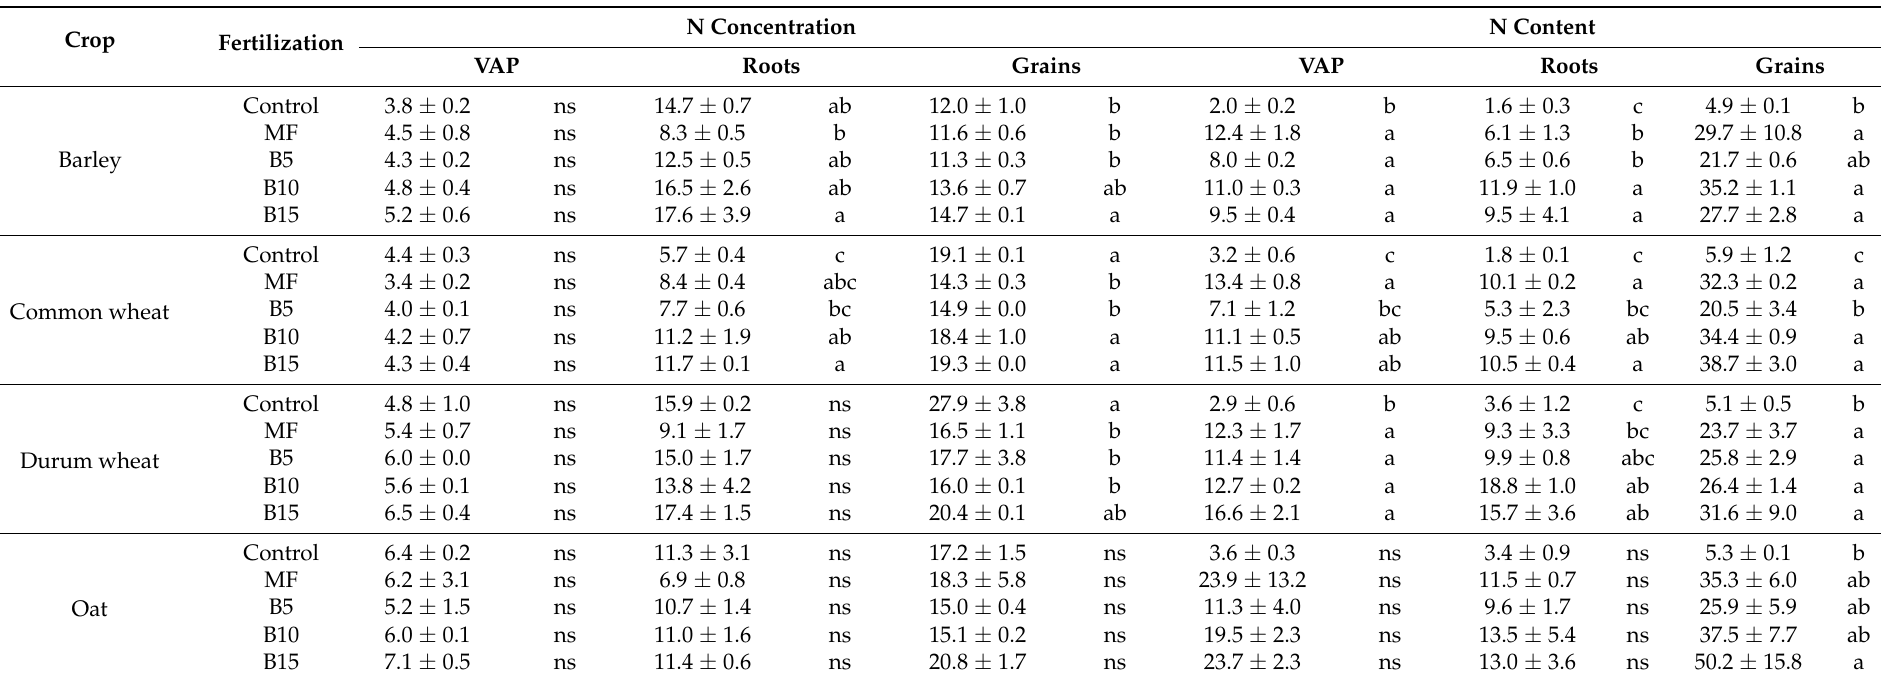
Table 6. Nitrogen concentration (g kg − 1 ) and content (mg plant − 1 ) of VAP, roots, and grains, as affected by fertilization treatment in barley, common wheat, durum wheat, and oat. N Concentration N Content Crop Fertilization VAP Roots Grains VAP Roots Grains